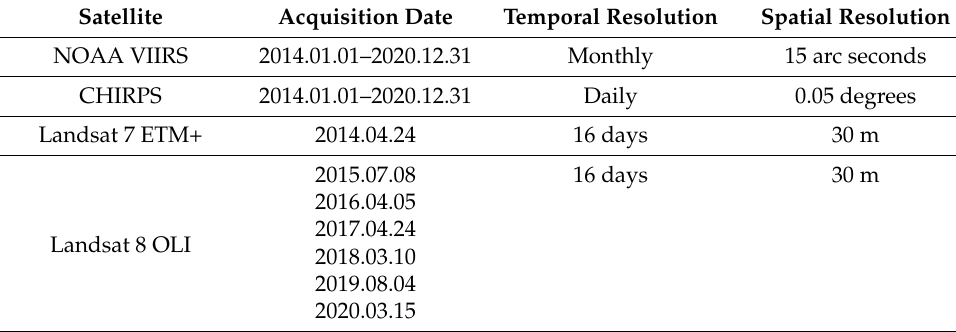
Table 1. Main specification of satellite imagery in the